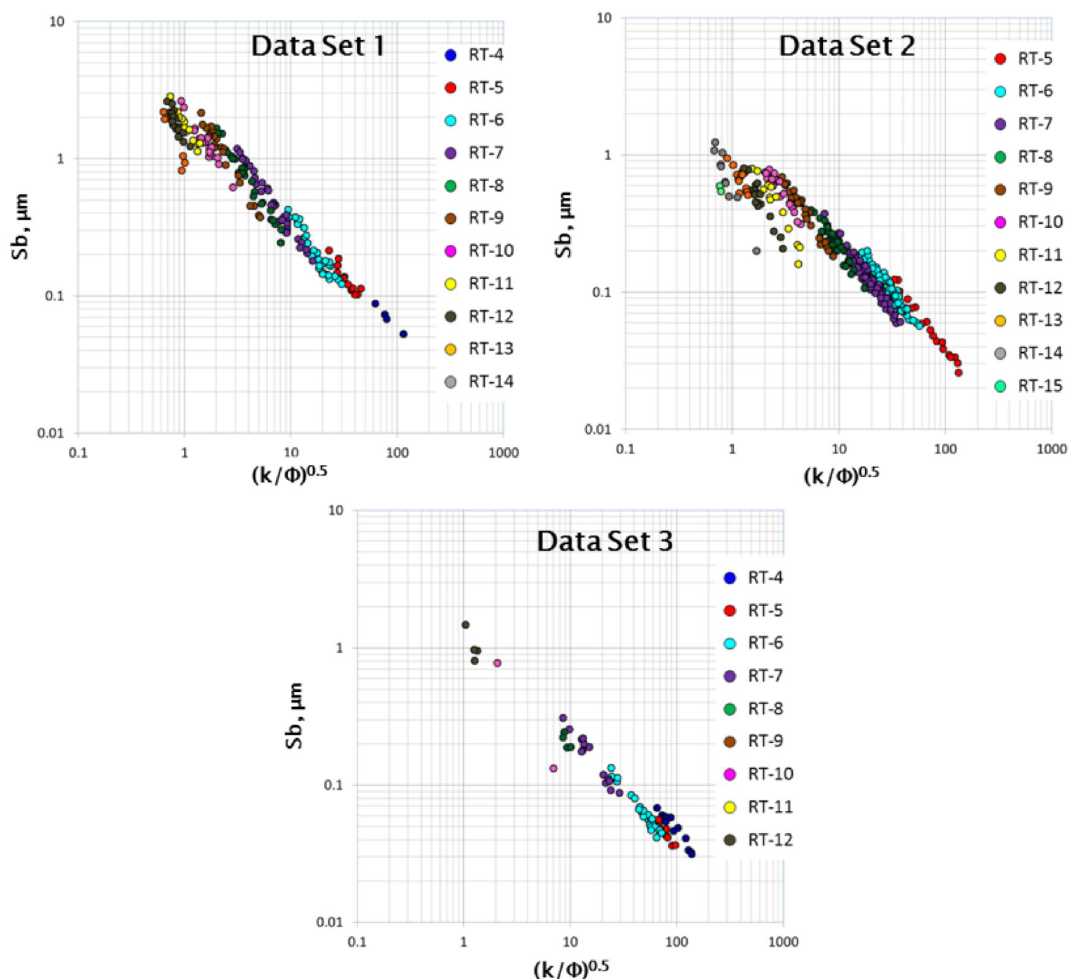
Fig. 5 Relationship of ( k/ϕ ) 0.5 with specific surface